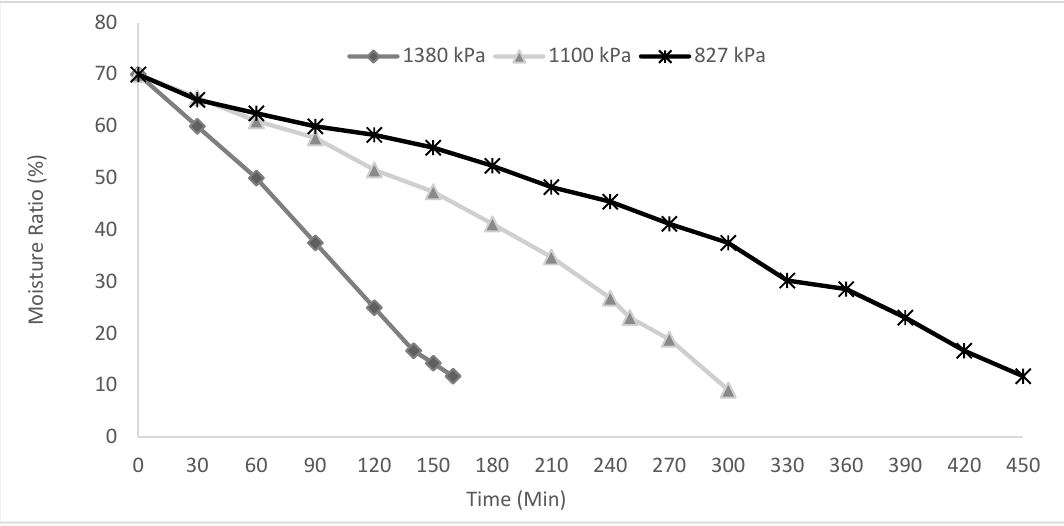
Figure 3. Moisture content variation as a function of compressor discharge pressure.